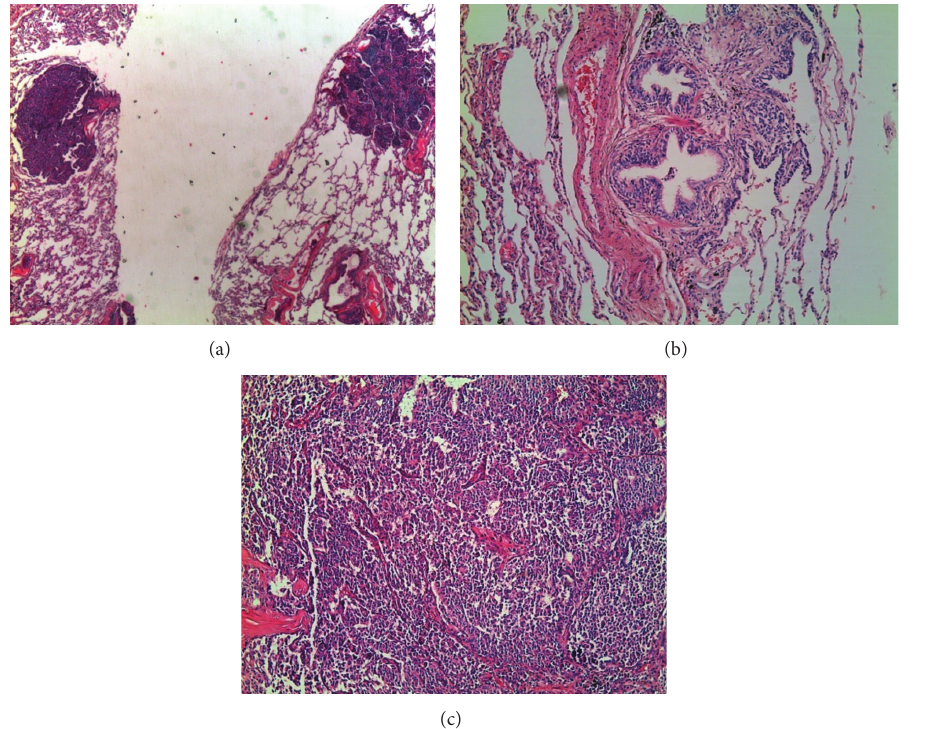
Figure 1: (a) Tumorlets HE × 2.5, (b) NE cell hyperplasia HE × 10, and (c) carcinoid tumor HE ×